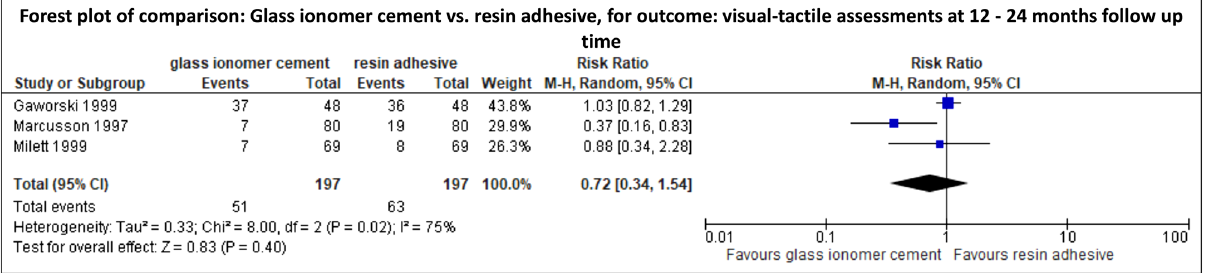
Figure 5. Meta-analysis for the comparison: glass ionomer cement vs. resin adhesive. Visual-tactile assessments were used to calculate RR und 95%